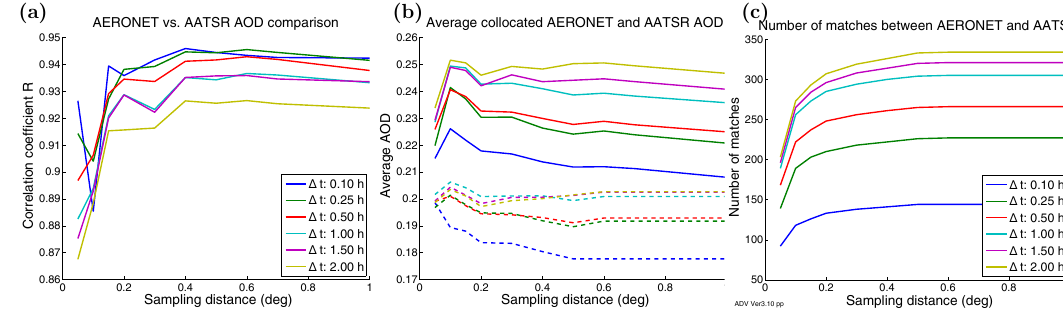
Figure 4. (a) Dependence of the AOD correlation coefficient R on the AATSR sampling distance d and AERONET sampling time window (cid:49)t . (b) Dependence of the average AOD of the sampled data on d and (cid:49)t . The solid lines show the AATSR values and the dashed lines of the corresponding color show the AERONET values. The line colors are the same as in panel (a) . (c) The number of matches between AATSR and AERONET as function of d and (cid:49)t